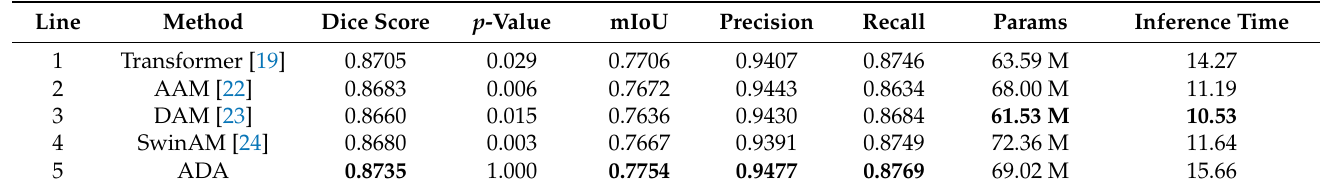
performance was shown in